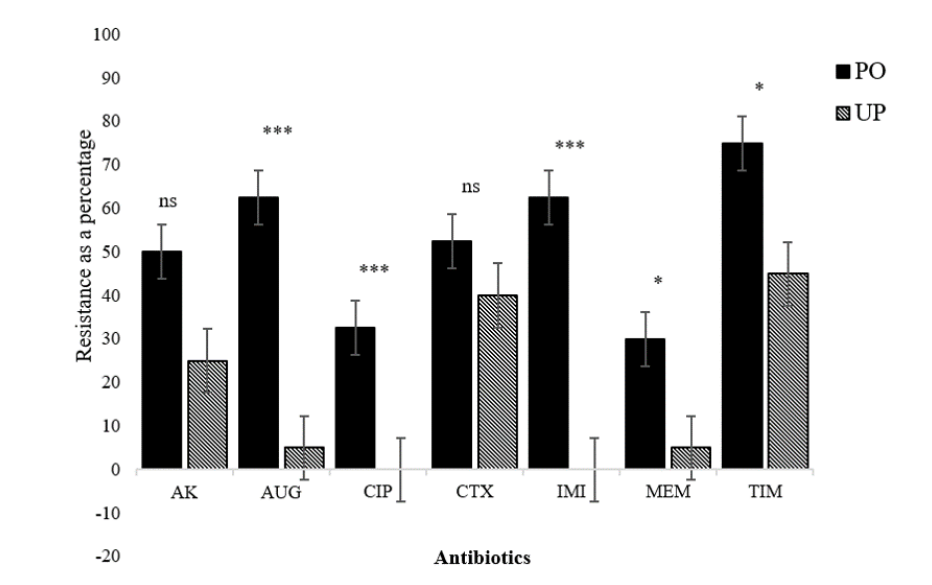
Figure 1: Antibiotic resistance (as a percentage of the total isolates) in bacterial isolates from polluted (PO) and unpolluted (UP) soils tested with seven antibiotics; ΑK – amikacin ( p = 0.096), ΑUG - amoxicillin-clavulanate ( p = 0.000), CIP – ciprofloxacin ( p = 0.000), CTX – cefotaxime ( p = 0.355), IMI – imipenem ( p = 0.000), MEM – meropenem ( p = 0.043), TIM - ticarcillin-clavulanate) ( p = 0.000). Probability values are following the two proportion